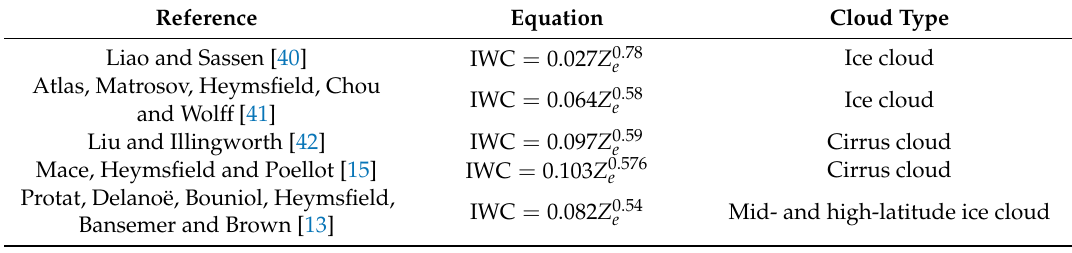
Table 3. Statistical empirical parameters for ice clouds using Ka-band MMCR observations. (The units